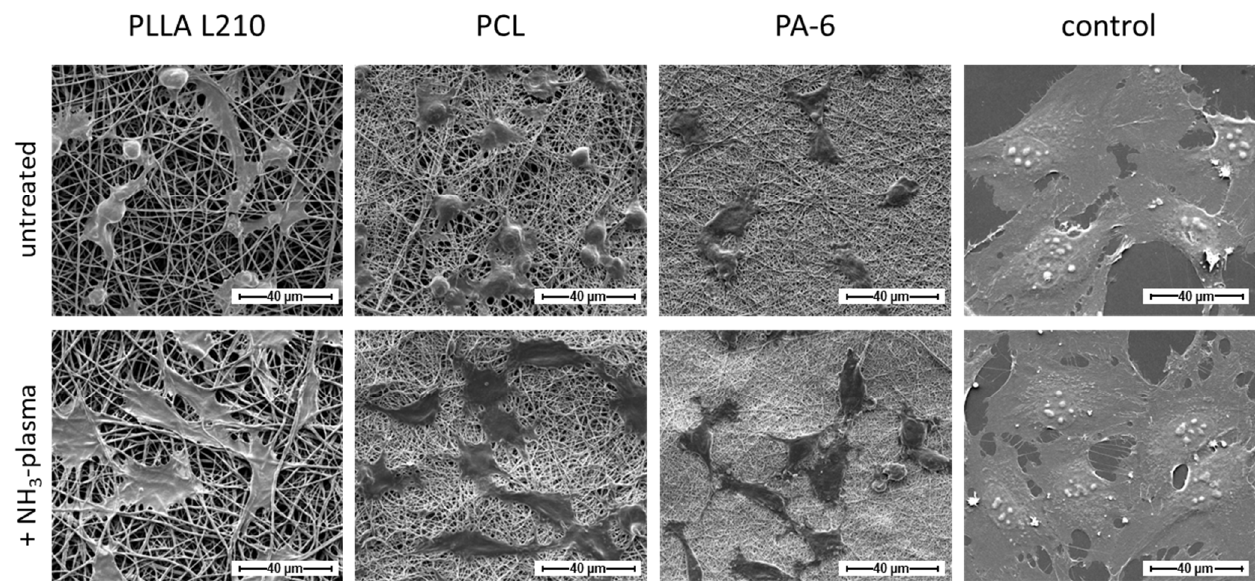
Figure 7. Cell morphology of human endothelial cells (EA.hy926) on untreated and NH3-plasma functionalized PLLA L210, PCL and PA-6 nonwovens and on a planar control surface (NC) after 48 h (SEM, bar = 40 µm).